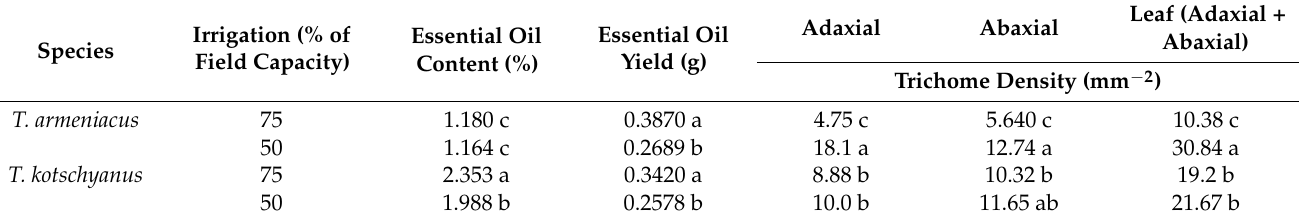
Table 4. Effect of irrigation regime on essential oil content and yield, as well as on leaf trichome density of two Thymus species. Assessments were conducted at 100% flowering. Within each column, different letters indicate significant differences ( n =